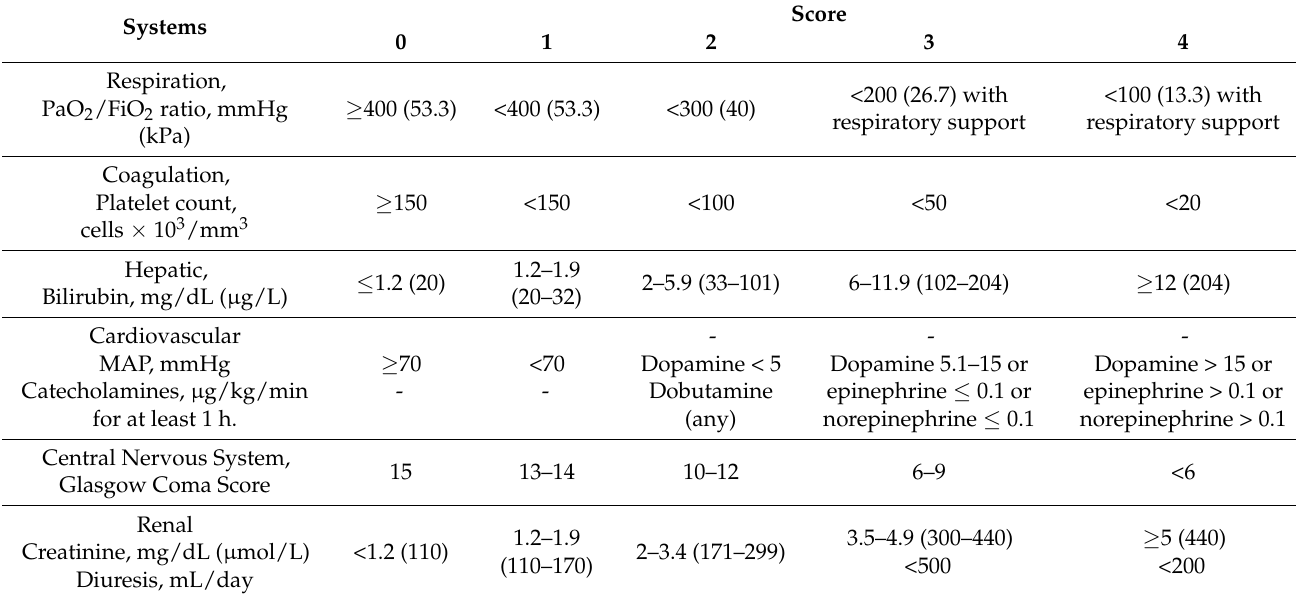
Table 1. The Sequential Organ Failure Assessment (SOFA)